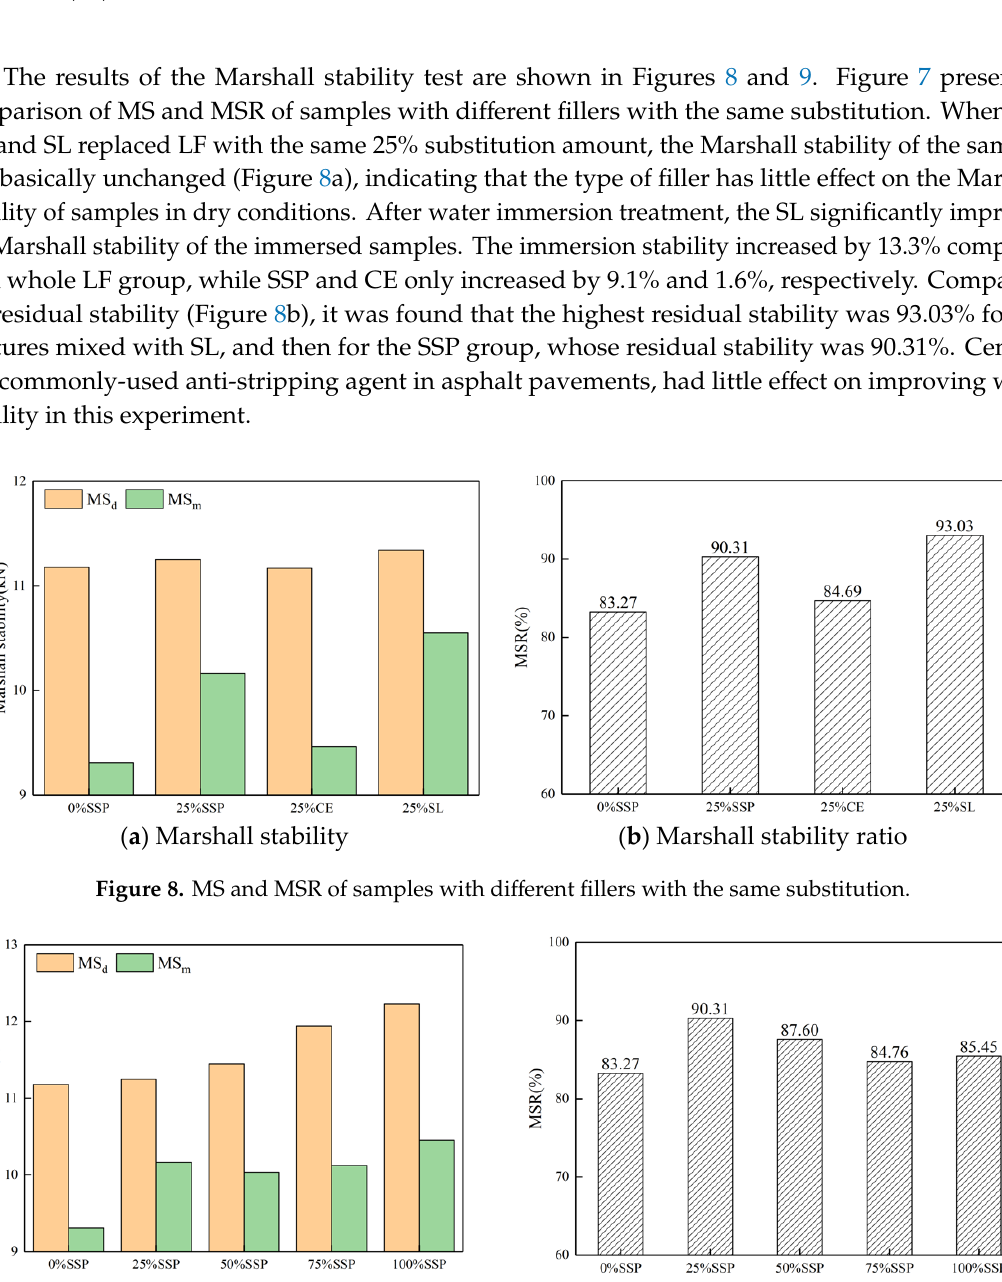
Figure 9. MS and MSR of samples with different substitution of SSP.